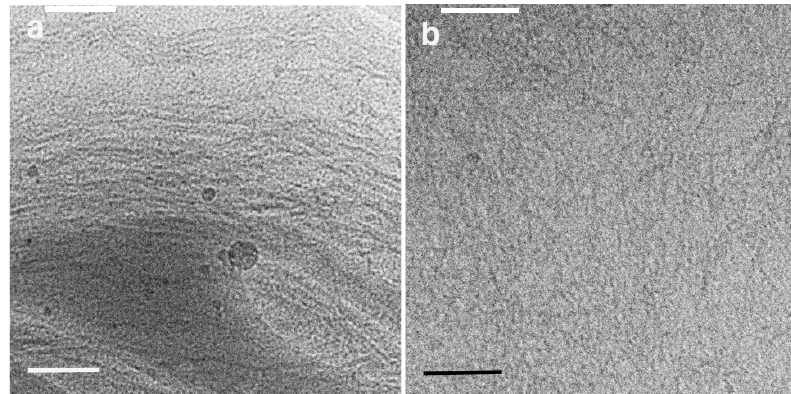
Figure 1. Cryo-transmission electronic microscopy (cryo-TEM) images of 0.5 wt % MCC dissolved in ( a ) 8 wt % NaOH(aq.) solution and ( b ) in 8 wt % NaOH(aq.)/12 wt % urea system. Scale bars correspond to 100 nm.